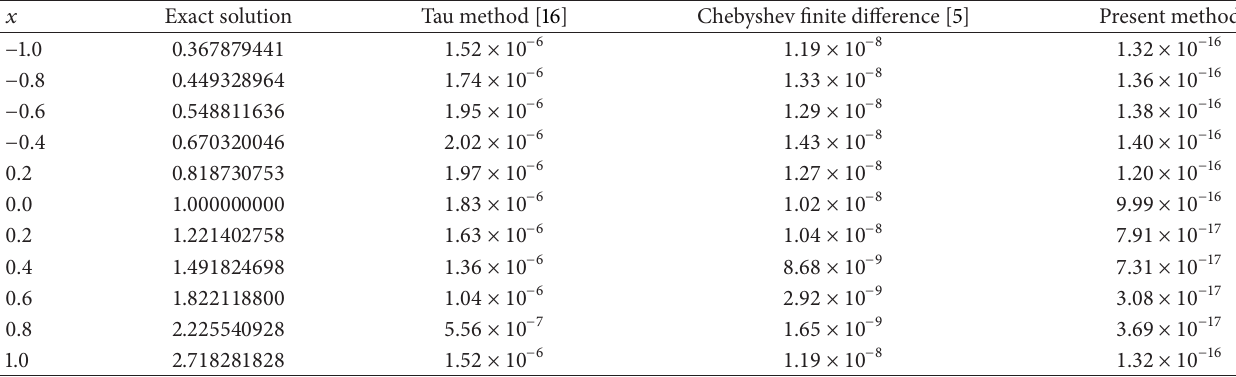
Table 5: A comparison of absolute errors between Tm, Cfm, and present method.